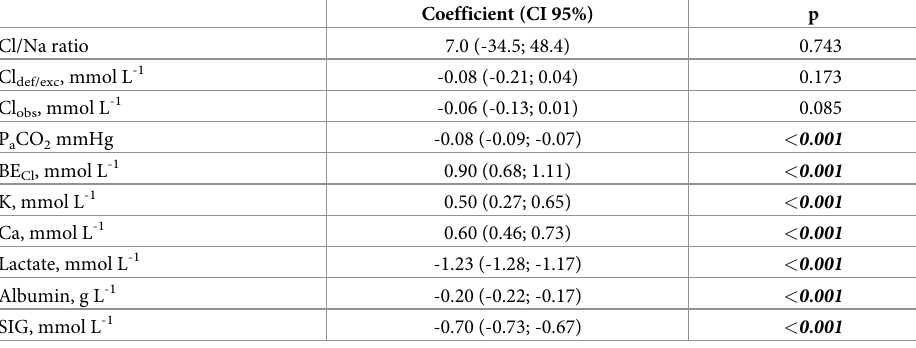
Table 5. Multivariate linear regression model for SBE (for all